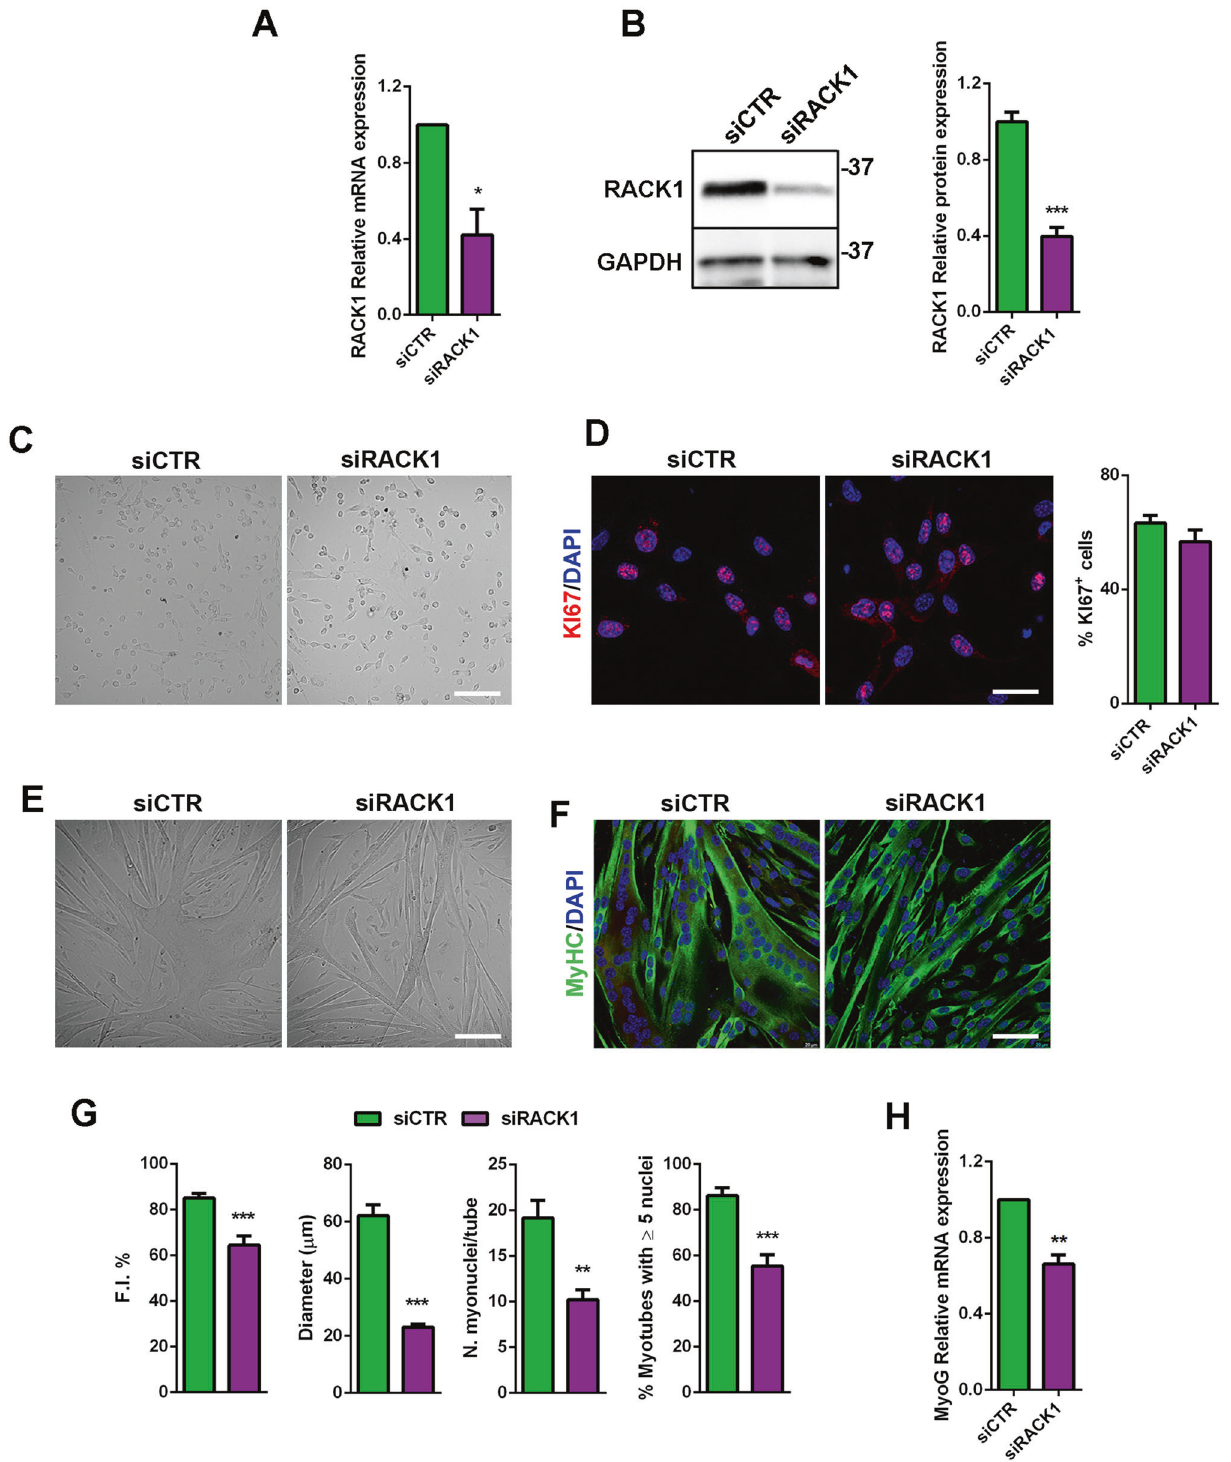
in vivo, also by interacting with catabolic systems such as autophagy [4, 36]. UPR and autophagy pathways play pivotal roles in regeneration of injured skeletal muscle [4, 36, 48]. While autophagy mechanisms in isolated mouse SC were not affected by RACK1 depletion, we observed increased levels of ATF3, 4, and 6 as well as CHOP and GRP78/BiP, thus indicating that RACK1-induced differentiation may involve, at least in part, the inhibition of